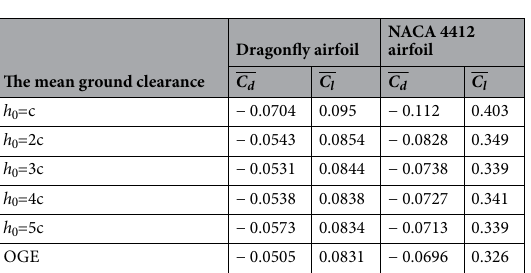
Table 4. The values of the average drag and lift coefficients over one oscillation period at various h 0 .